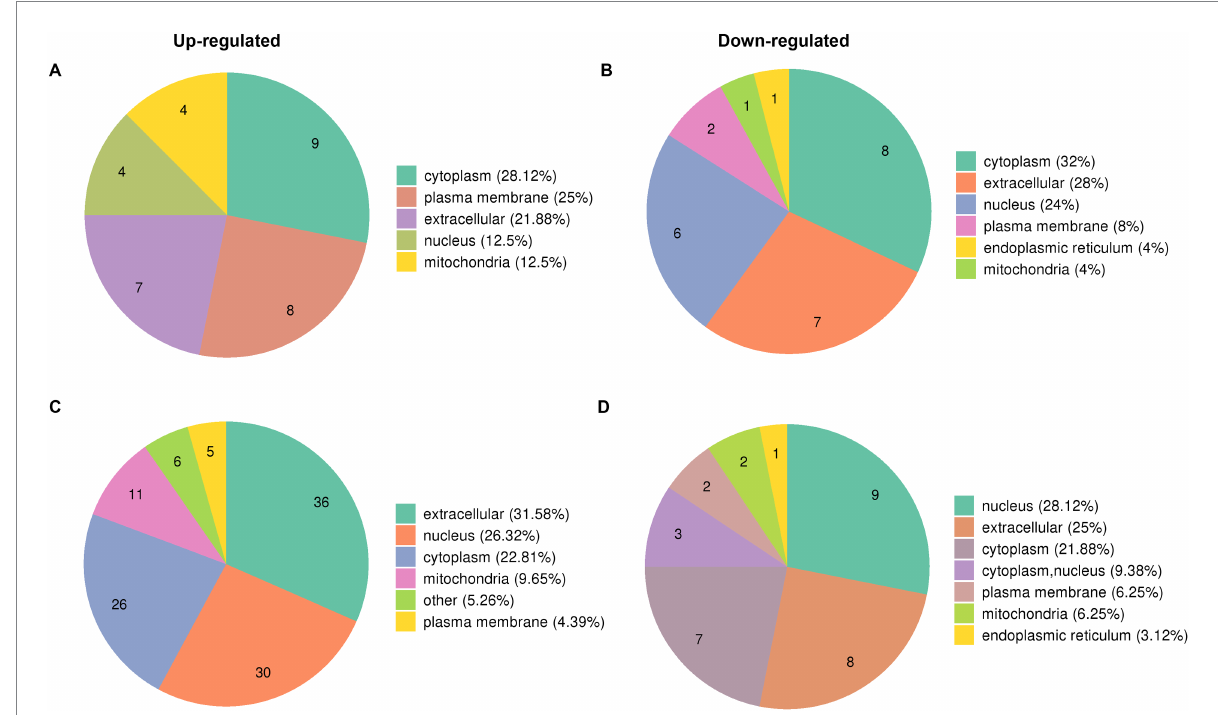
FIGURE 3 Subcellular localization of DEPs proteins in KO-d0 vs. WT-d0 and KO-d3 vs. WT-d3 groups after influenza virus infection. (A) The distribution of up-regulated proteins in KO-d0 vs. WT-d0 group at 0 dpi. (B) The distribution of down-regulated proteins in KO-d0 vs. WT-d0 group at 0 dpi. (C) The distribution of up-regulated proteins in KO-d3 vs. WT-d3 group at 3 dpi. (D) The distribution of down-regulated proteins in KO-d3 vs. WT-d3 group at 3 dpi.